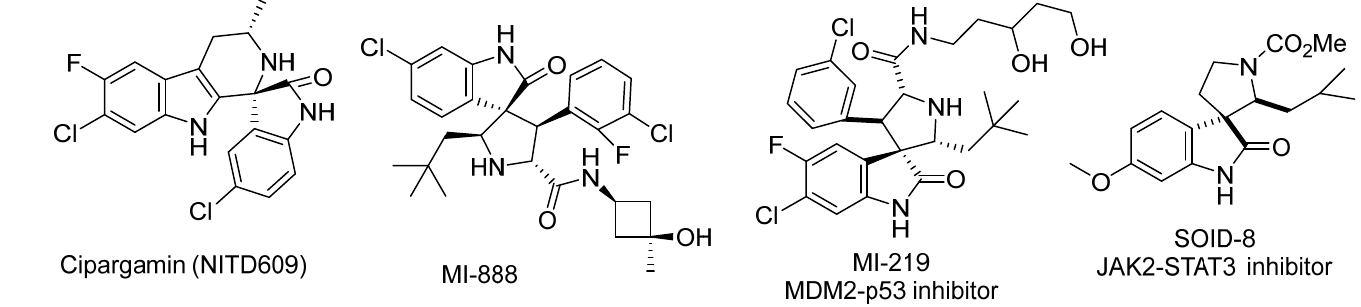
Figure 2. Cipargamin (NITD609), MI-888, MI-219 and SOID-6 representatives of potent biologically active spirooxindoles.